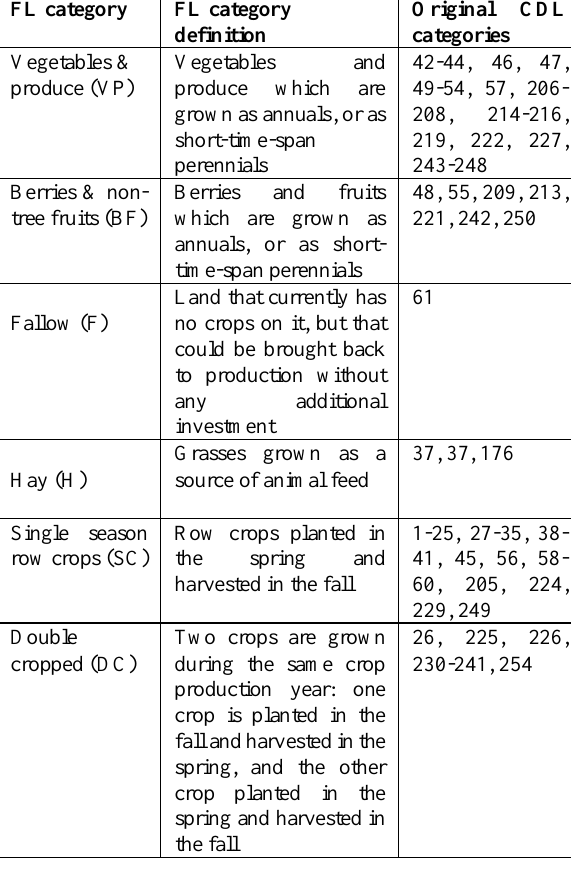
Table 2: Six farmland (FL) categories. Note: The complete list of the original CDL categories is available in USDA/NASS (2020). The FL data is overlaid with FDP data to obtain the maps and the estimates of the areas. Then results were summaries in the form of charts.